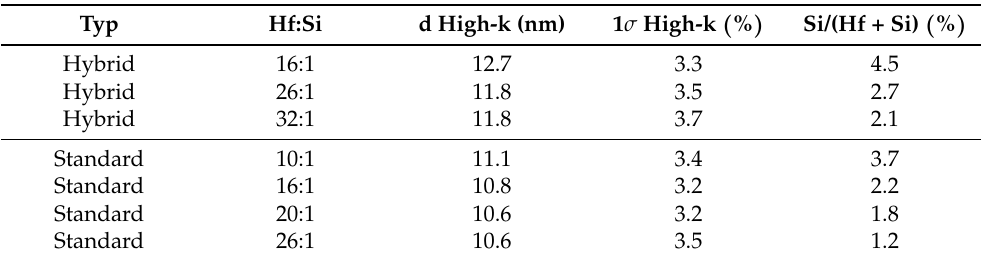
Table 1. Film thickness and composition measured using spectral ellipsometry and X-ray photoelec- tron spectroscopy.